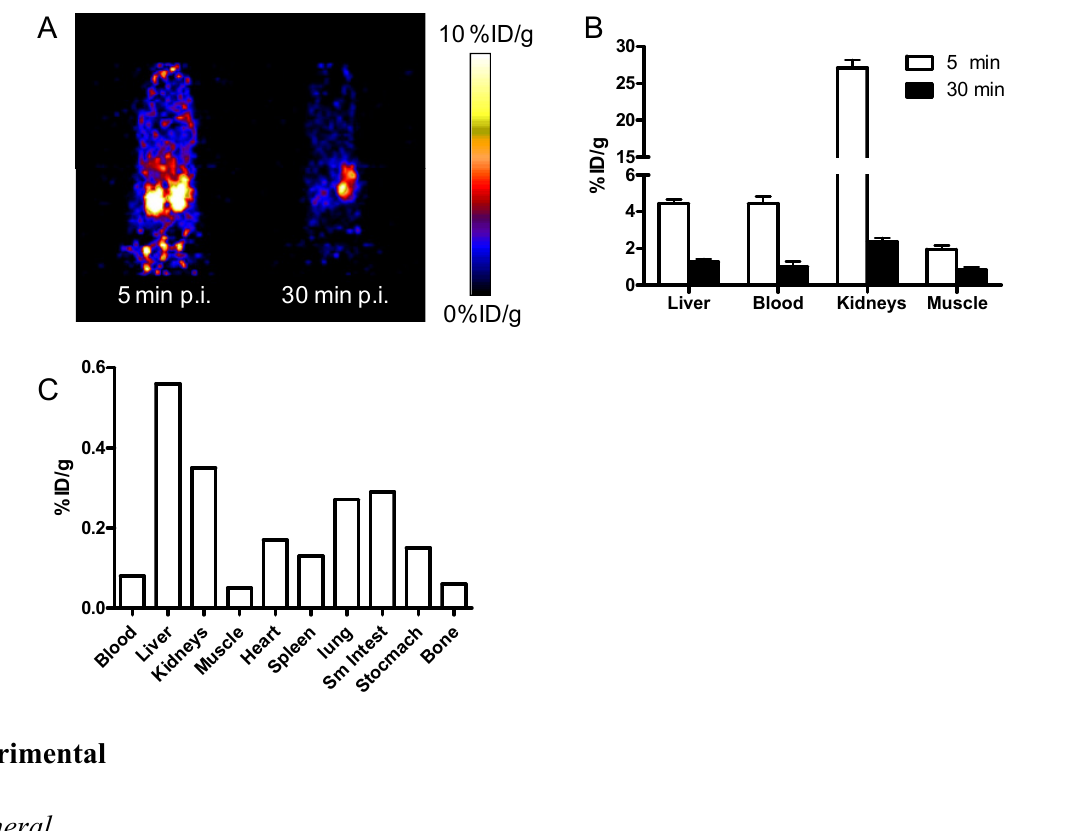
Figure 2. ( A ) Decay-corrected whole-body coronal microPET images of athymic female nude mice from a static scan at 5 min, and 30 min after injection of 64 Cu-Ba ( B ) microPET quantification of major organs at 5 min, and 30 min after injection of 64 Cu-Ba Sar. The data are expressed as average ± standard deviation, n = 3. ( C ) 3 Sar in normal female nude mouse at 24 h after Biodistribution studies of 64 Cu-Ba 3